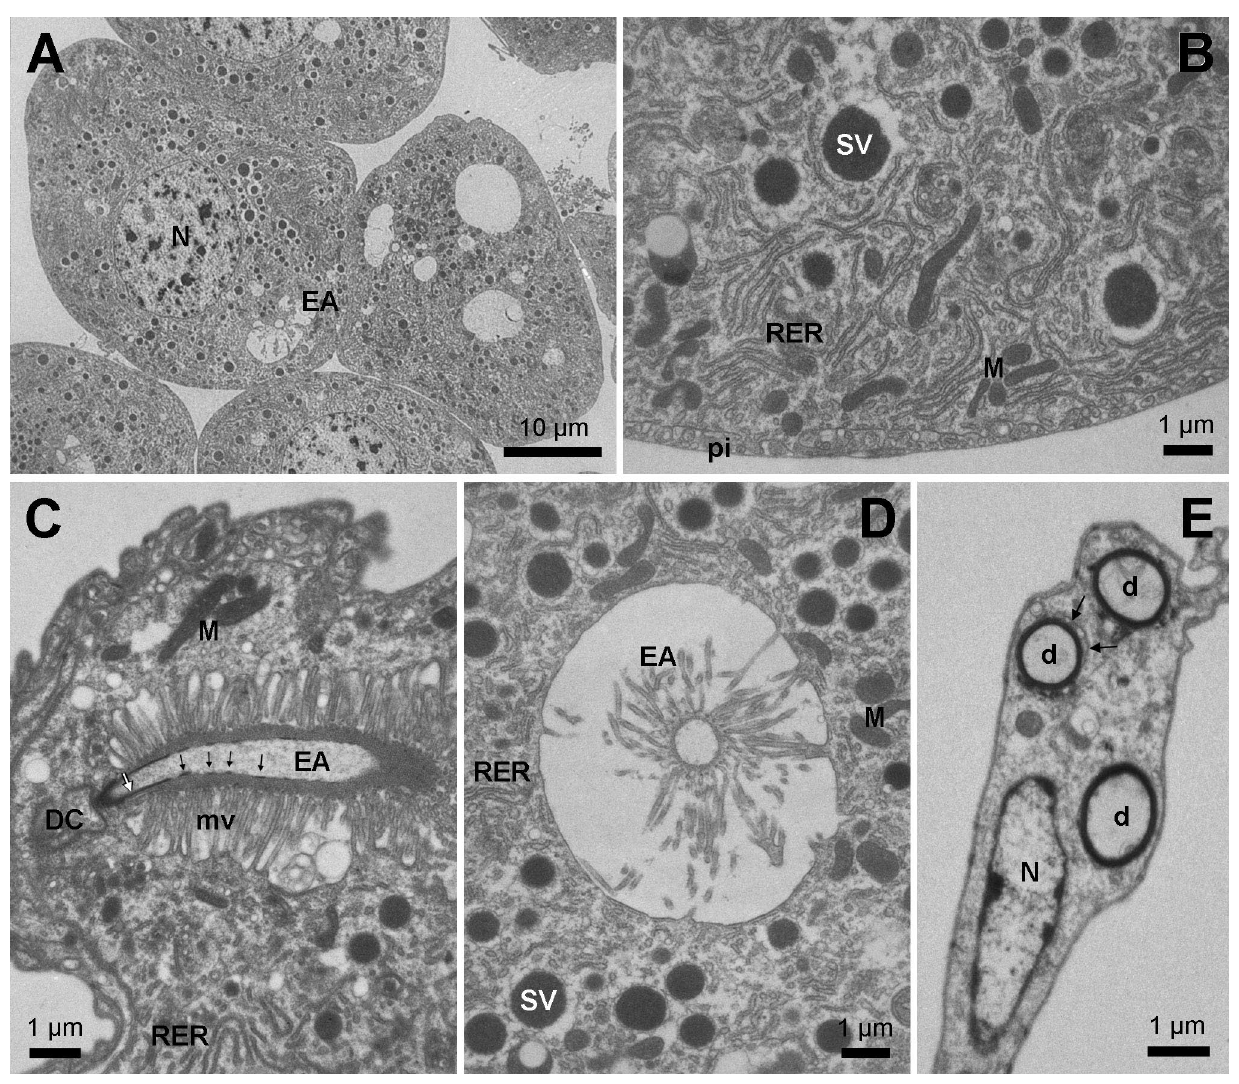
Fig 3 . Electron micrographs of the propharyngeal gland. A . Survey of rounded secretory cells with centrally located spherical nucleus. B . Cytoplasmic detail showing well-developed granular endoplasmic reticulum. C . Detail of end apparatus with regular microvillar organization near junction with duct cell (white arrow points to continuous epicuticle near junction with duct cell, black arrows indicate regions with separated epicuticle). D . Detail of end apparatus with distorted microvillar organization. E . Detail of duct cell with scarce cytoplasm. Arrows indicate junction with second duct cell (the 2 ducts at the right side represent sections of the same sinuous duct within a single duct cell). d: ducts, DC: duct cell, EA: end apparatus, M: mitochondria, mv: microvilli, N: nucleus, RER: granular endoplasmic reticulum, SV: secretory